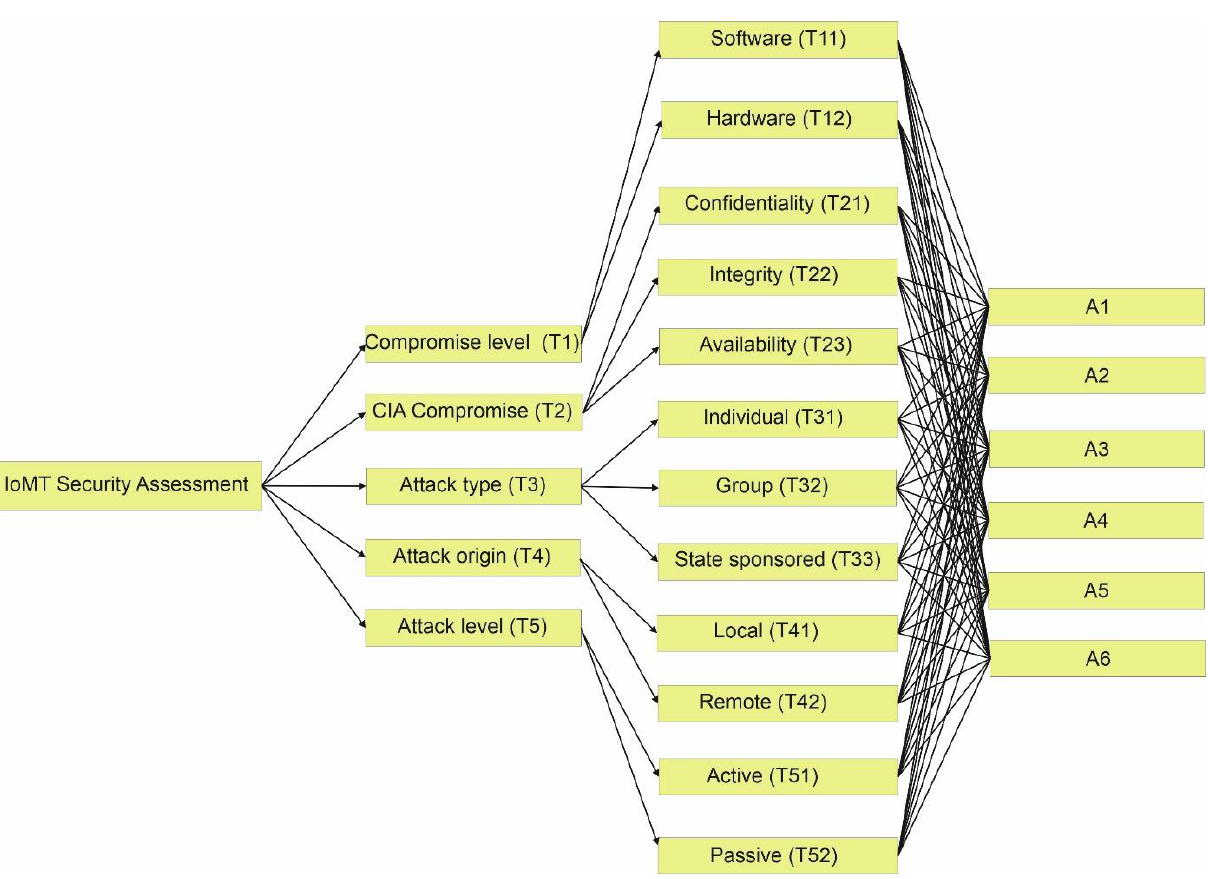
Figure 2. Hierarchy for the security evaluation of IoMT.